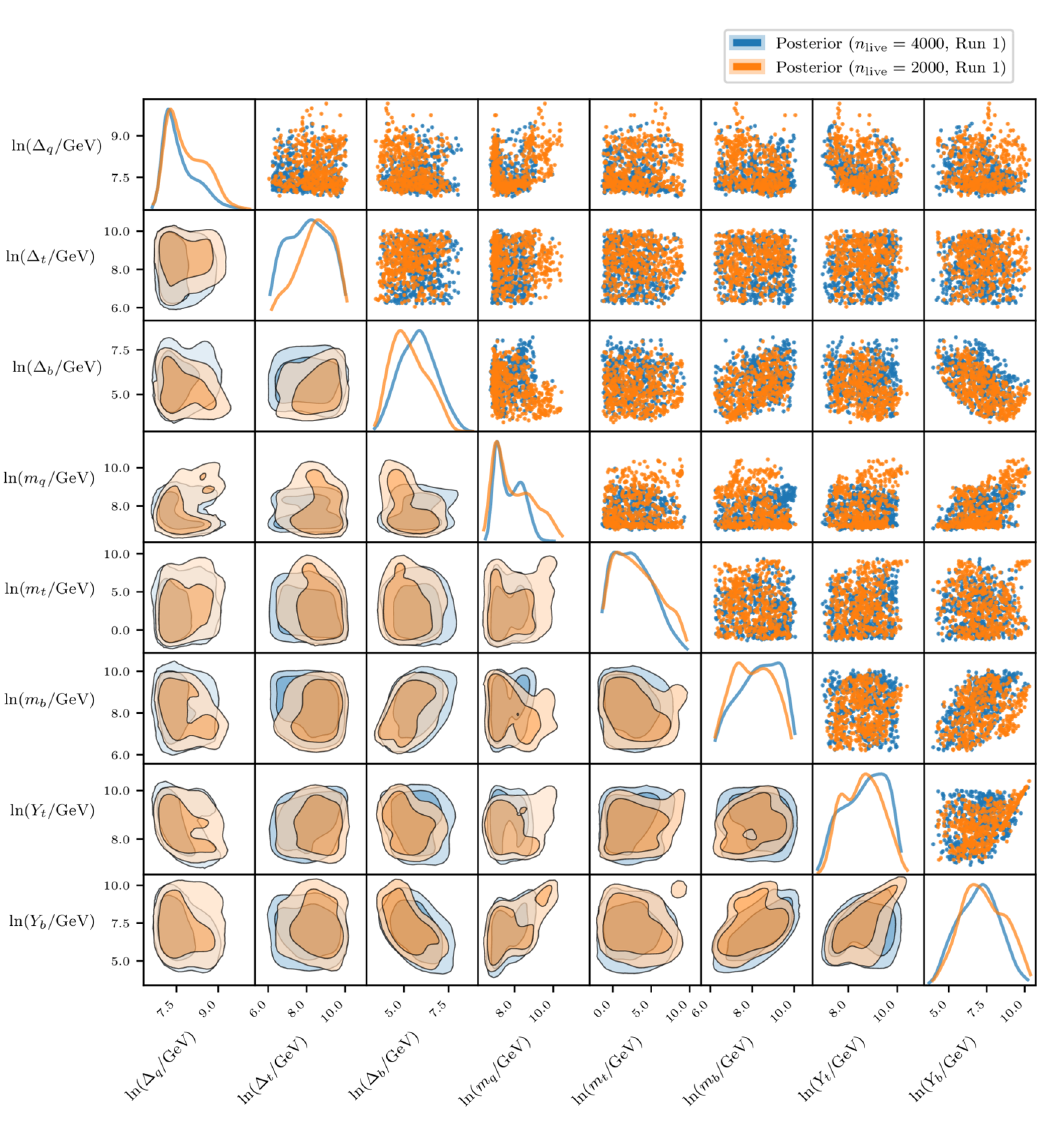
Figure 24. 1D and 2D marginalised posteriors for the fermion sector parameters in the M4DCHM 14 − 1 − 10 found in two different runs with 2000 and 4000 live points